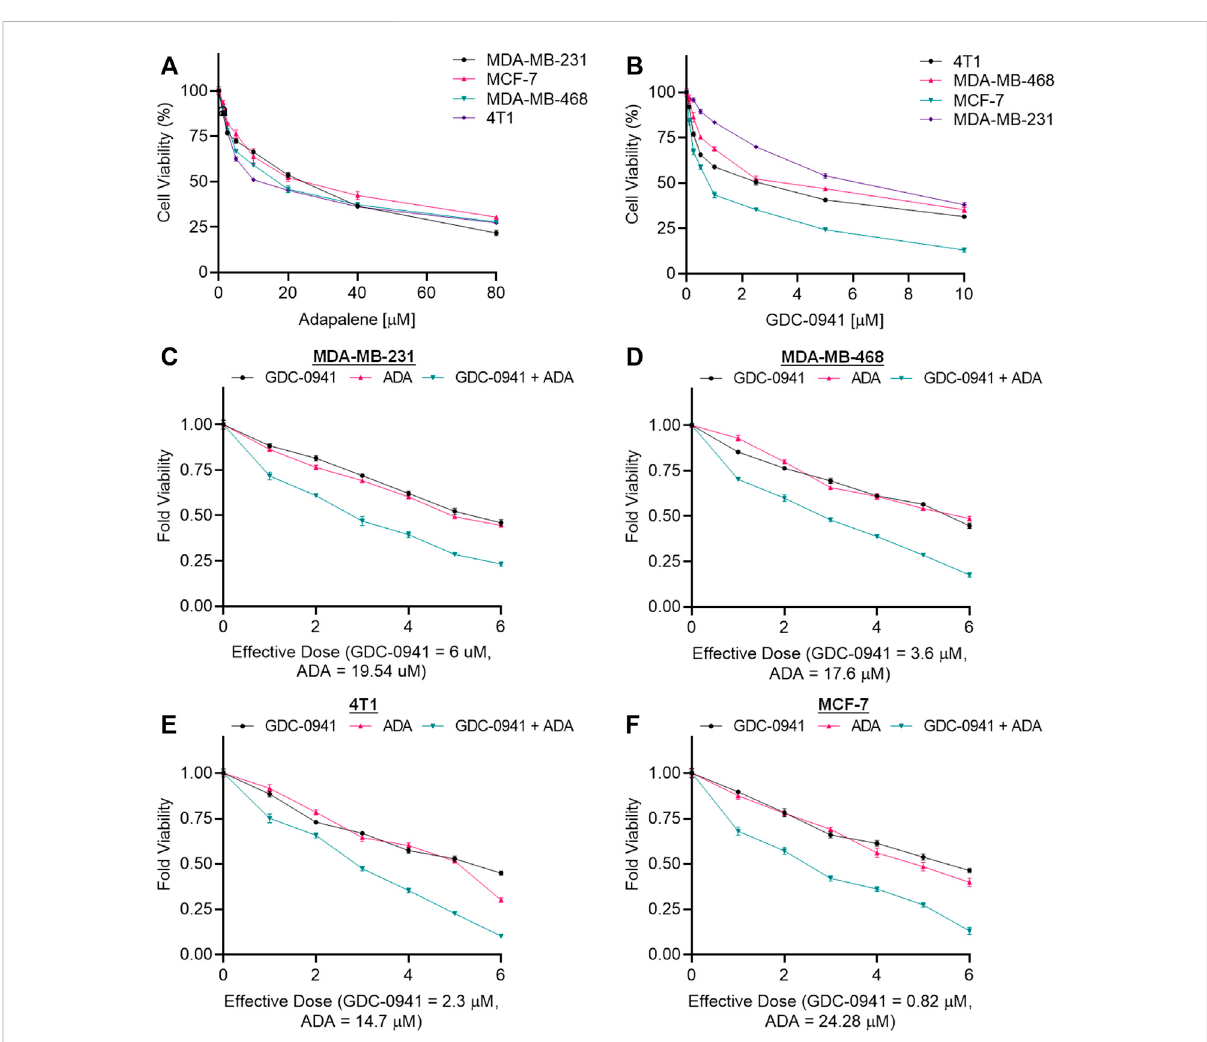
FIGURE 1 Adapalene and GDC reduce TNBC cell growth in vitro . Single-drug cytotoxicity assays of (A) . adapalene and (B) GDC-0941 in TNBC cell lines and MCF-7 cells. Both ADA and GDC inhibited tumor growth in a dose-dependent manner. The IC 50 values were calculated using GrpahPad Prism V8.4.3. Combination treatment shows an enhanced reduction in cell growth in (C) . MDA-MB-231 (D) . MDA-MB-468 (E) . 4T1 and (F) MCF-7 cells. Enhanced reduction in cell viability was observed upon combination treatment with ADA and GDC, indicating positive pharmacodynamic